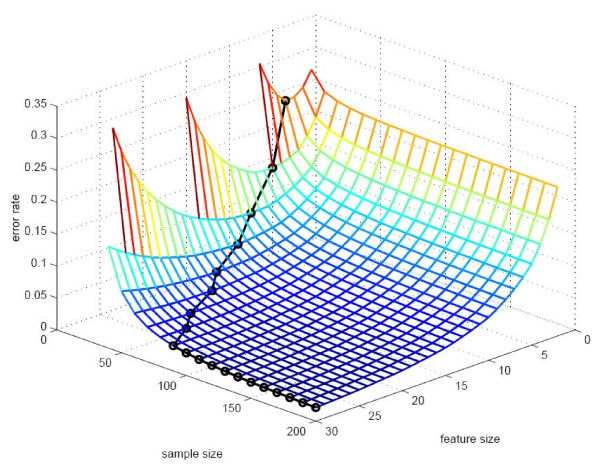
Peaking phenomenon for LDA with slightly correlated features.